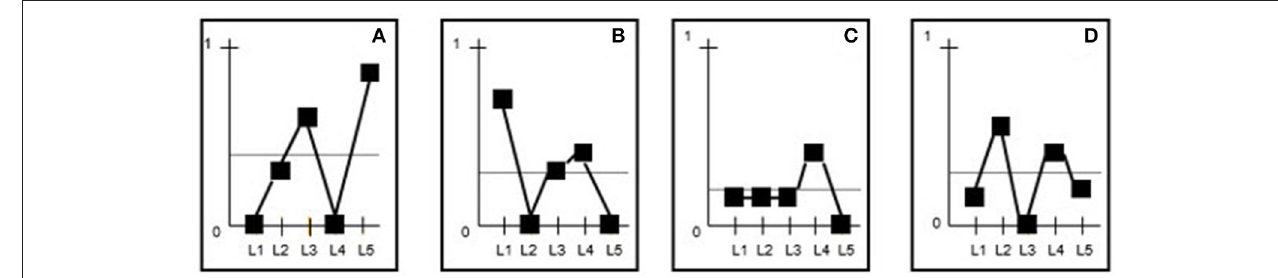
FIGURE 1 | (A–D) The lags are shown on the X-axis and the probabilities on the Y-axis. Based on the results from Table 5b , the values corresponding to the unconditional probabilities (first row) are indicated by the horizontal line parallel to the X-axis (e.g., 0.35 for category A). Also shown are the values for each of the conditional probabilities for each category and lag. These values are linked by a (generally uneven) line for each category. The horizontal line parallel to the X-axis represents the upper limit for the effect of chance. Accordingly, any conditional probabilities in the subsequent lags that are higher than the unconditional probability for the corresponding category are significant and hence form part of the behavioral pattern.